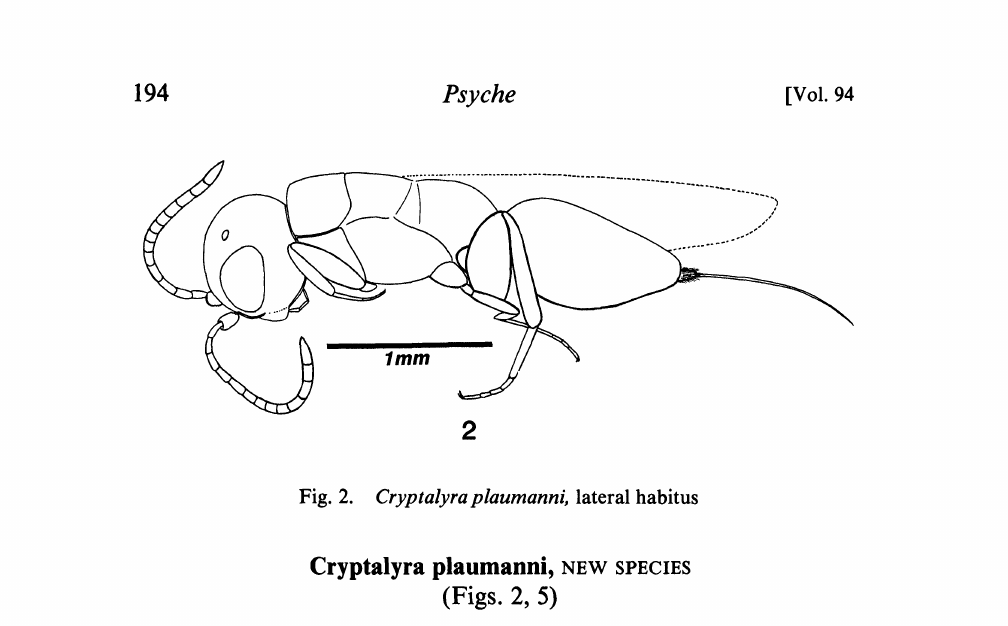
Fig. 2. CryptalyraplaumannL lateral habitus Cryptalyra plaumanni, IEW SPECIES (Figs. 2,